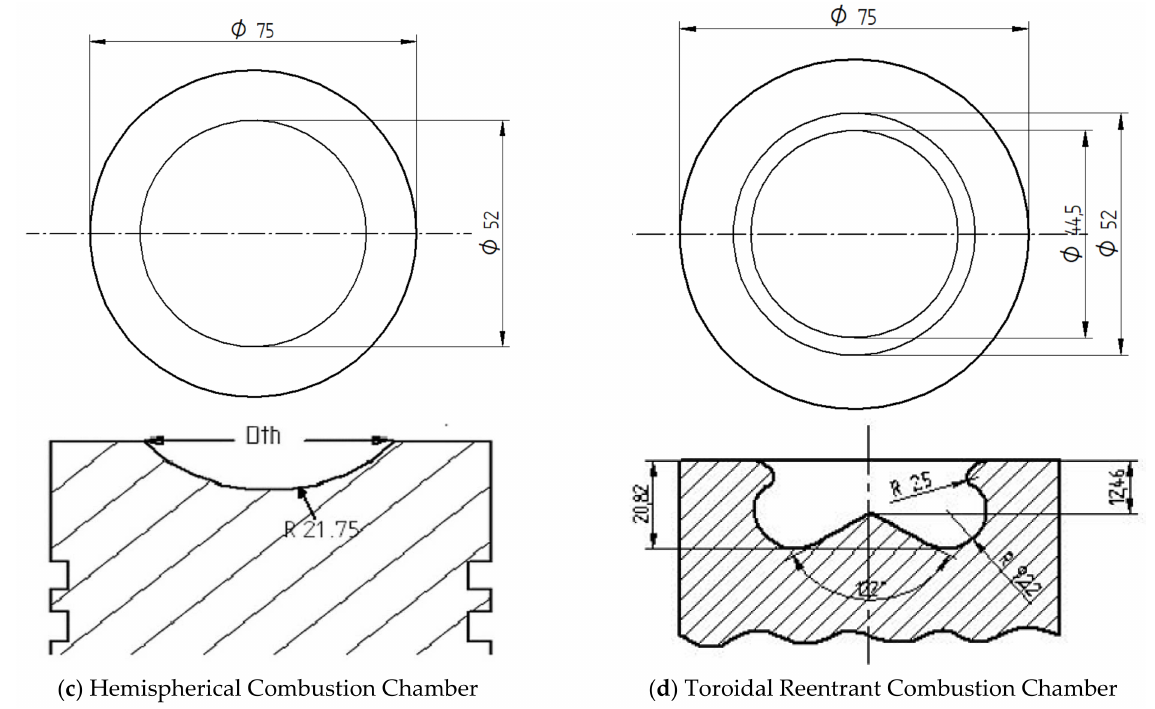
Figure 3. Combustion chamber types